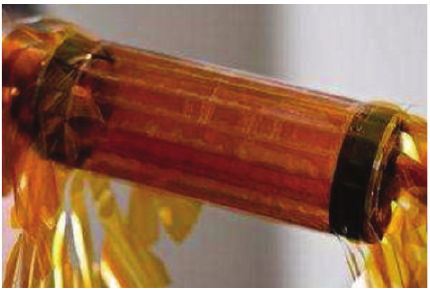
Figure 21: Mechanical prototype of the Mu3e inner pixel detector